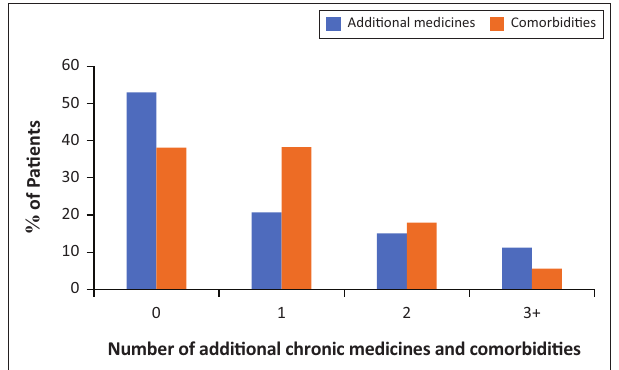
FIGURE 1: Distribution of comorbidities and additional chronic medicines amongst elderly patients receiving antiretroviral therapy at Newlands Clinic in March